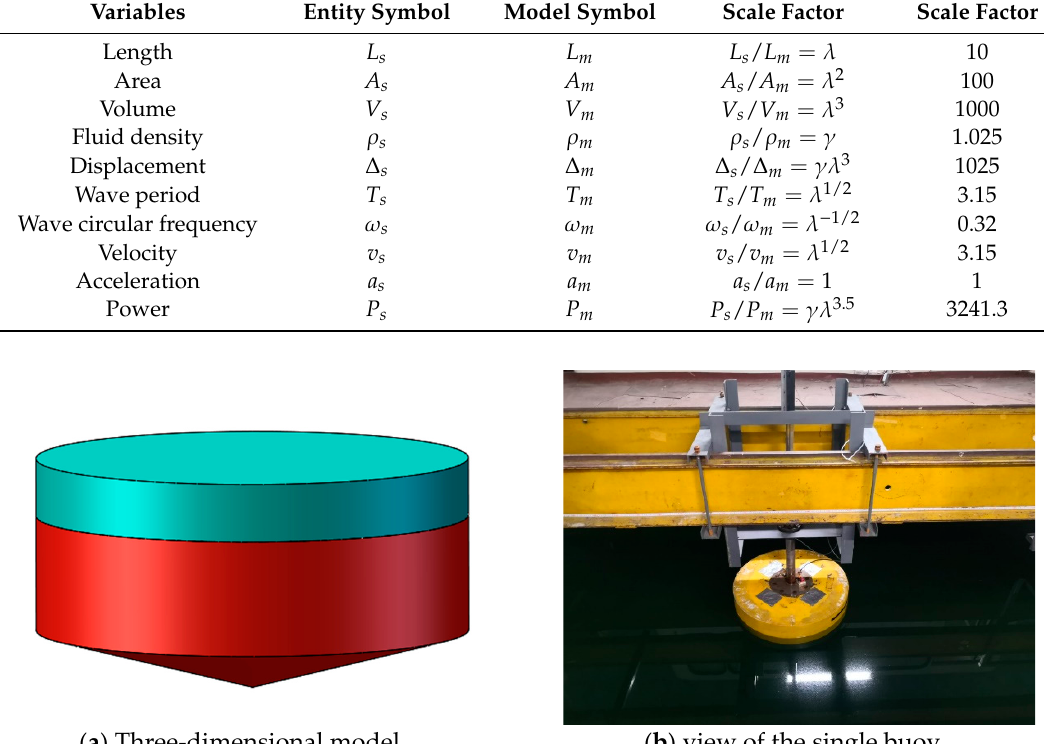
Table 1. The scale comparison.